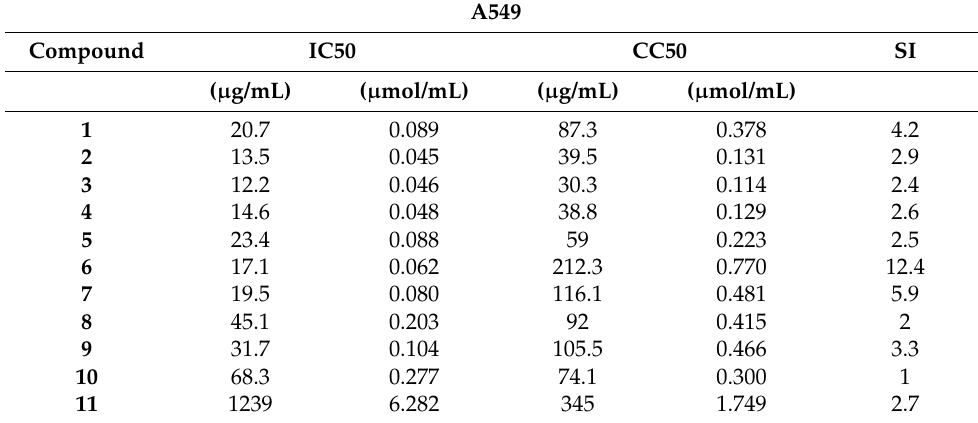
Table 1. IC50 and CC50 values and selectivity index (SI) obtained after treatment of A549 cell line with RSV derivatives 1 – 11 . IC50: the concentration of compound causing 50% reduction in viral infection. CC50: the concentration of compound required to reduce cell viability by 50%. IC50 and CC50 are expressed in µ g/mL or µ mol/mL. The Selectivity Index (SI) of each compound was calculated as the ratio of